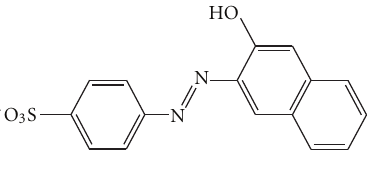
F 1: Structure of